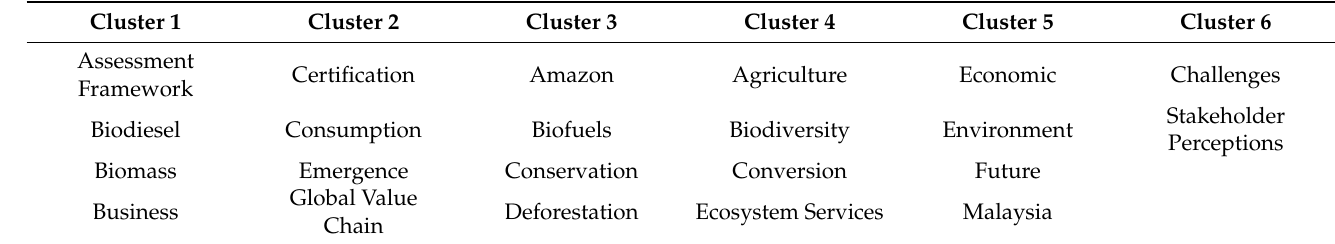
Table 7. Cluster table (all